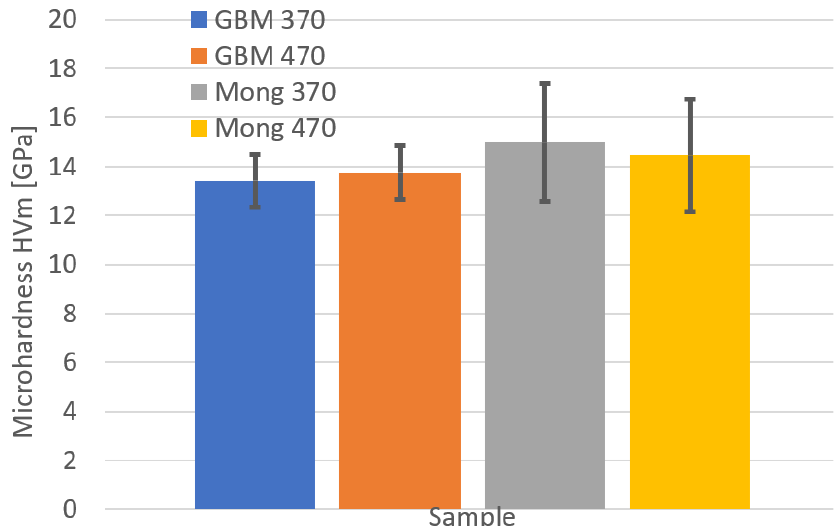
Figure 4. Microhardness of the coatings.